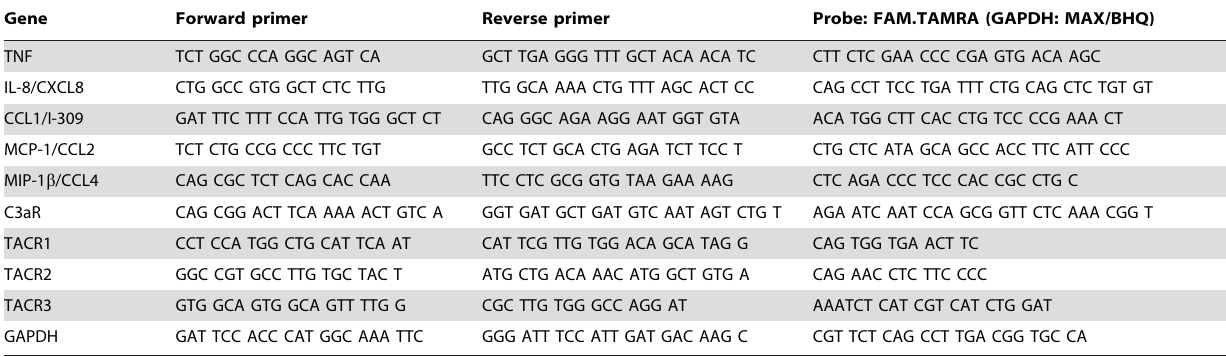
Gene Forward primer Reverse primer Probe: FAM.TAMRA (GAPDH: